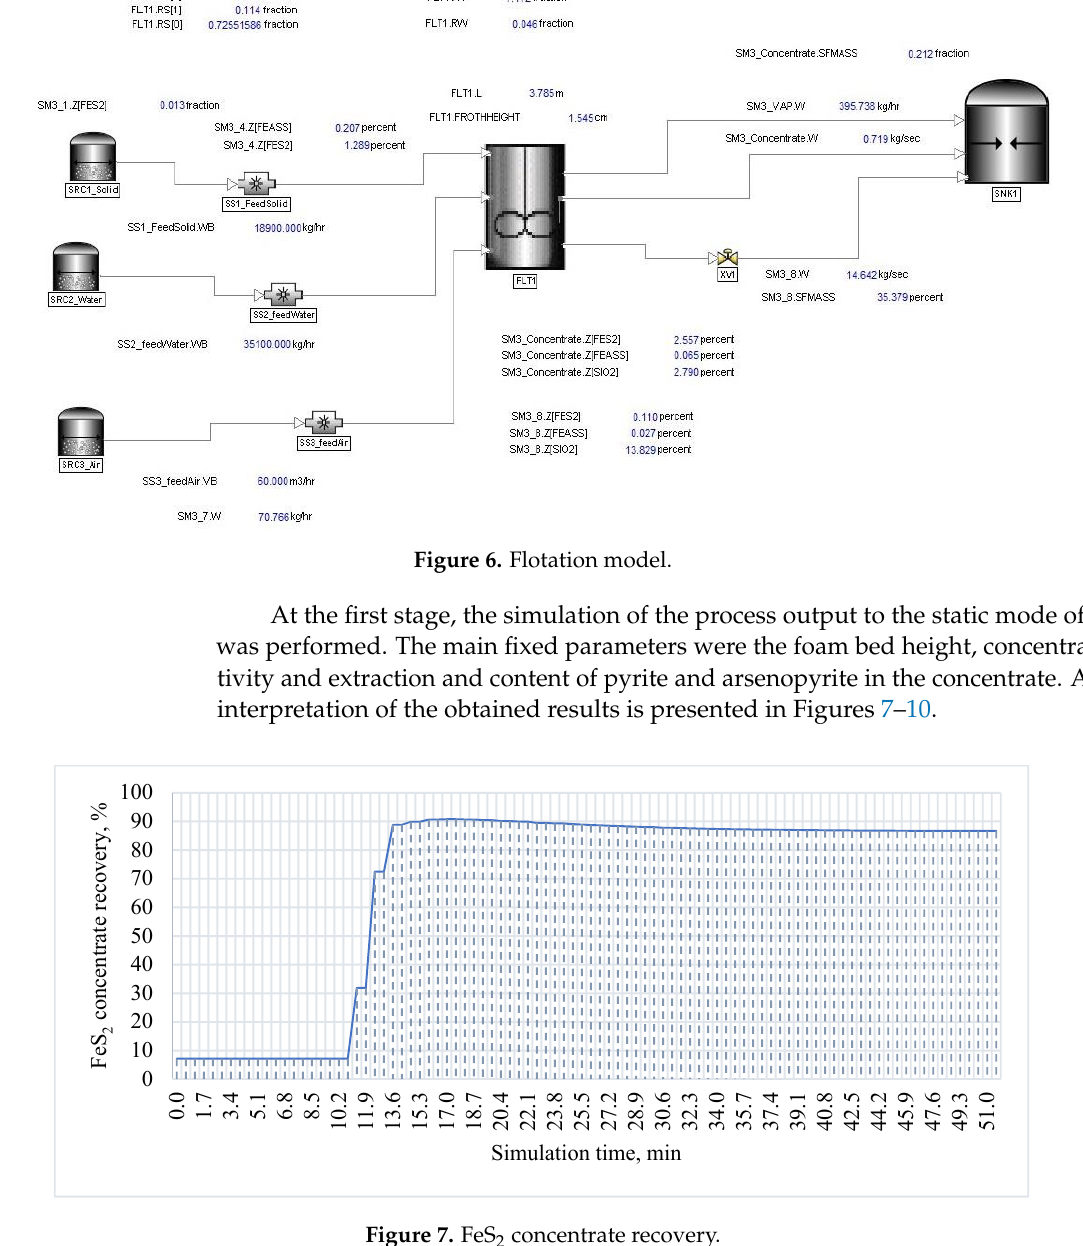
. Figure 8 . FeS 2 concentrate grade. Figure 9. FeAsS concentrate recovery.